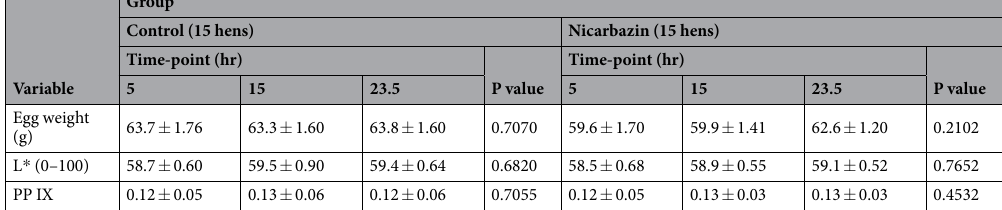
Table 4. Mean values ( ± S.E.) of egg quality variables measured before dividing hens into different groups (time-points and nicarbazin treatment). Protoporphyrin IX (PP IX) was measured in nMoles per gram of whole eggshell. The eggs were collected before dividing the experimental hens into various groups. On the basis of eggshell variables, hens were divided into groups in such a way that the variables were not significantly different among